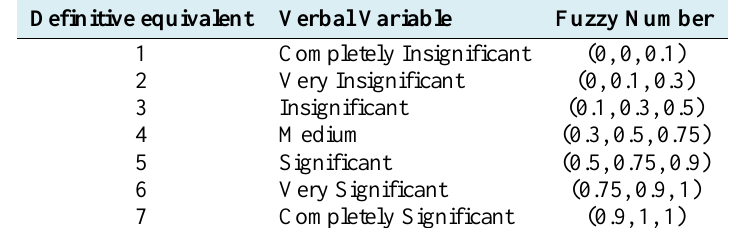
Table 4. 7-point Likert scale with corresponding Fuzzy triangle numbers for value evaluation Definitive